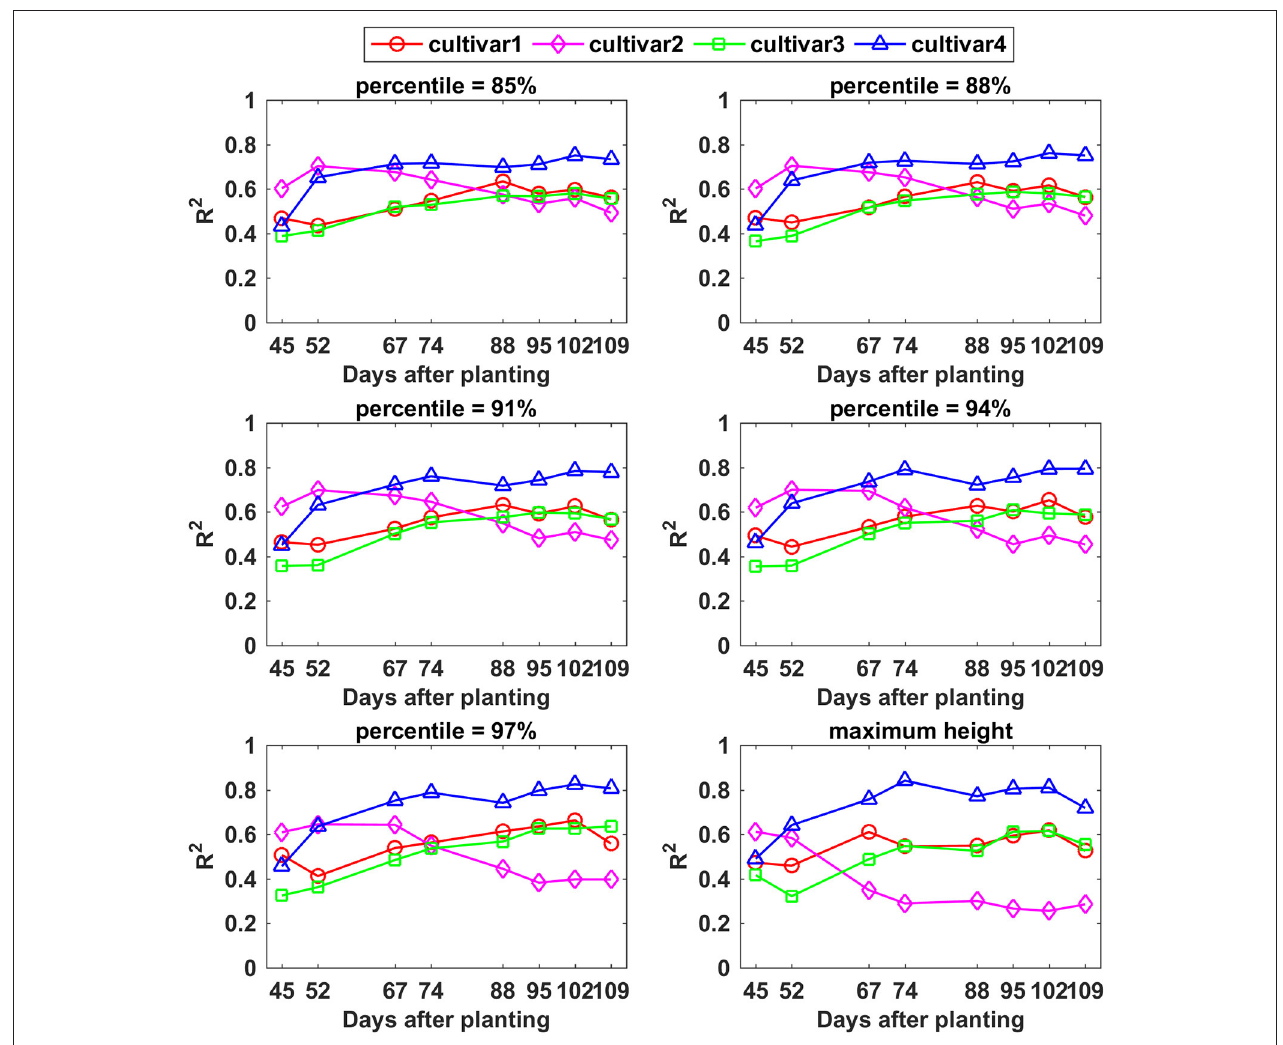
FIGURE 10 | Correlation analysis results between different percentiles of canopy height and yield by days after planting for each